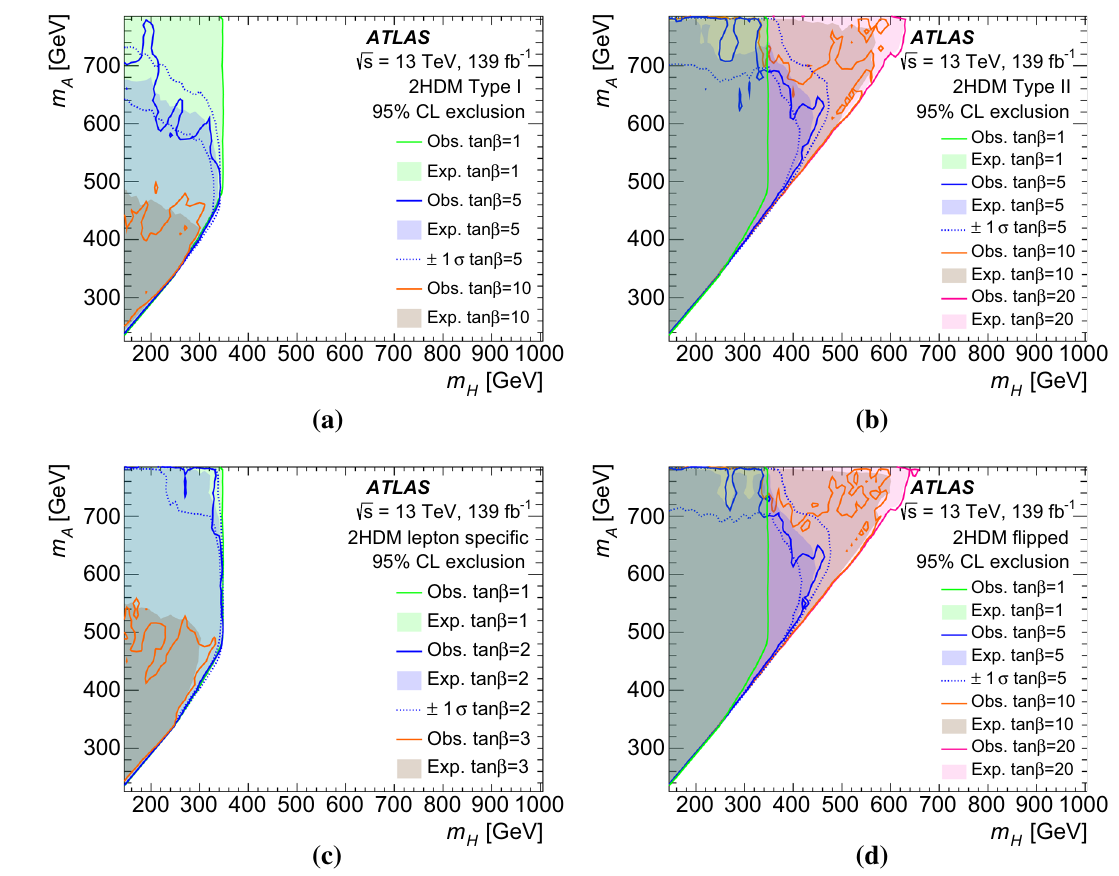
Fig. 10 Observed and expected 95% CL exclusion regions for the (cid:6)(cid:6) bb channel in the ( m H , m A ) plane for various tan β values for the a type-I, b type-II, c lepton-specific and d flipped 2HDM, with cos (β − α) = 0